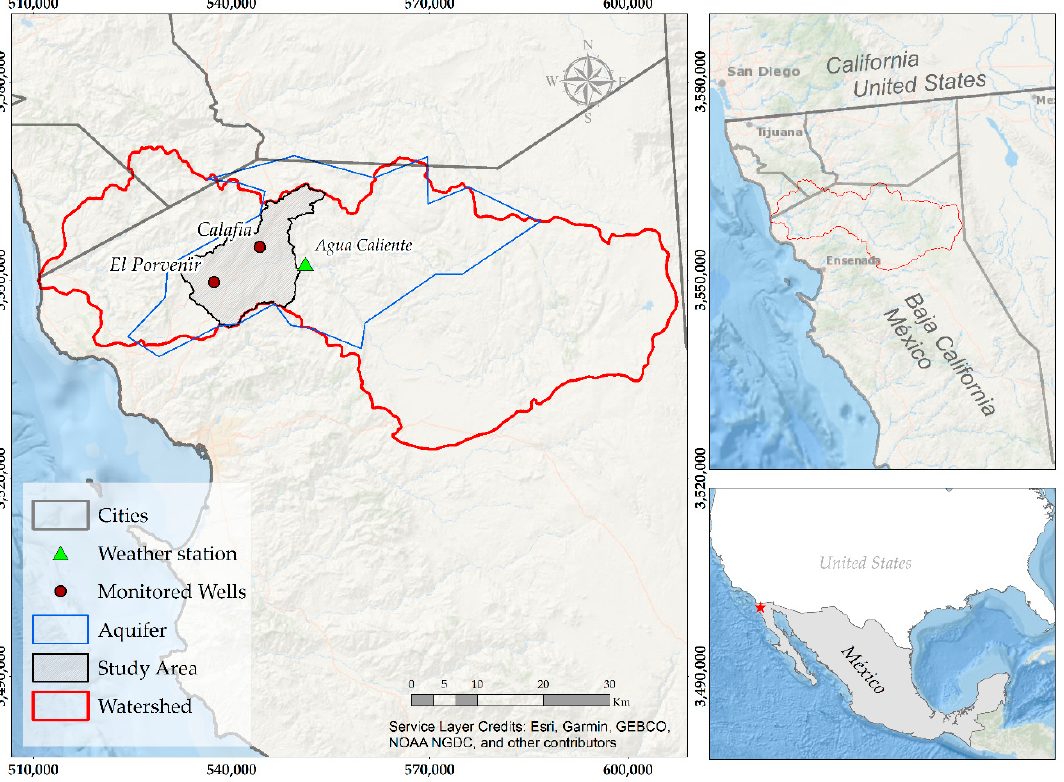
Figure 3. Location of the study area.